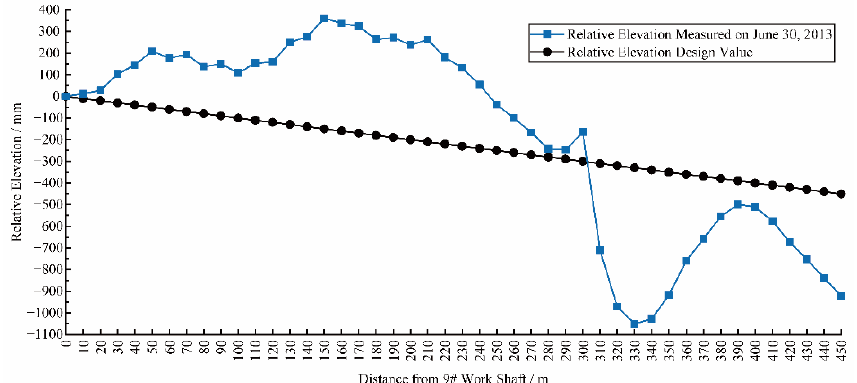
Figure 2. Longitudinal relative elevation curve of the tunnel on 30 June 2013.